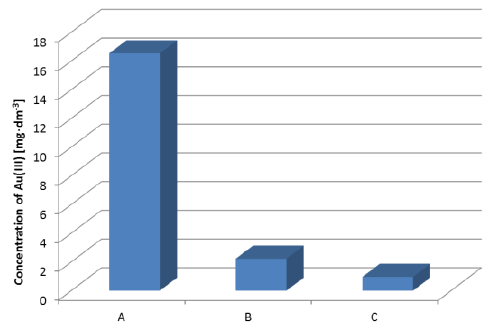
Figure 9. Removal of Au(III) ions from the solution the pin leaching: A — the initial concentration of gold(III) ions. B — the concentration of gold(III) ions after the sorption on Purolite MN 202. C — the gold(III) ions. B—the concentration of gold(III) ions after the sorption on Purolite MN 202. concentration of gold(III) ions after the sorption on Purolite MN 202 impregnated with Cyanex 272.